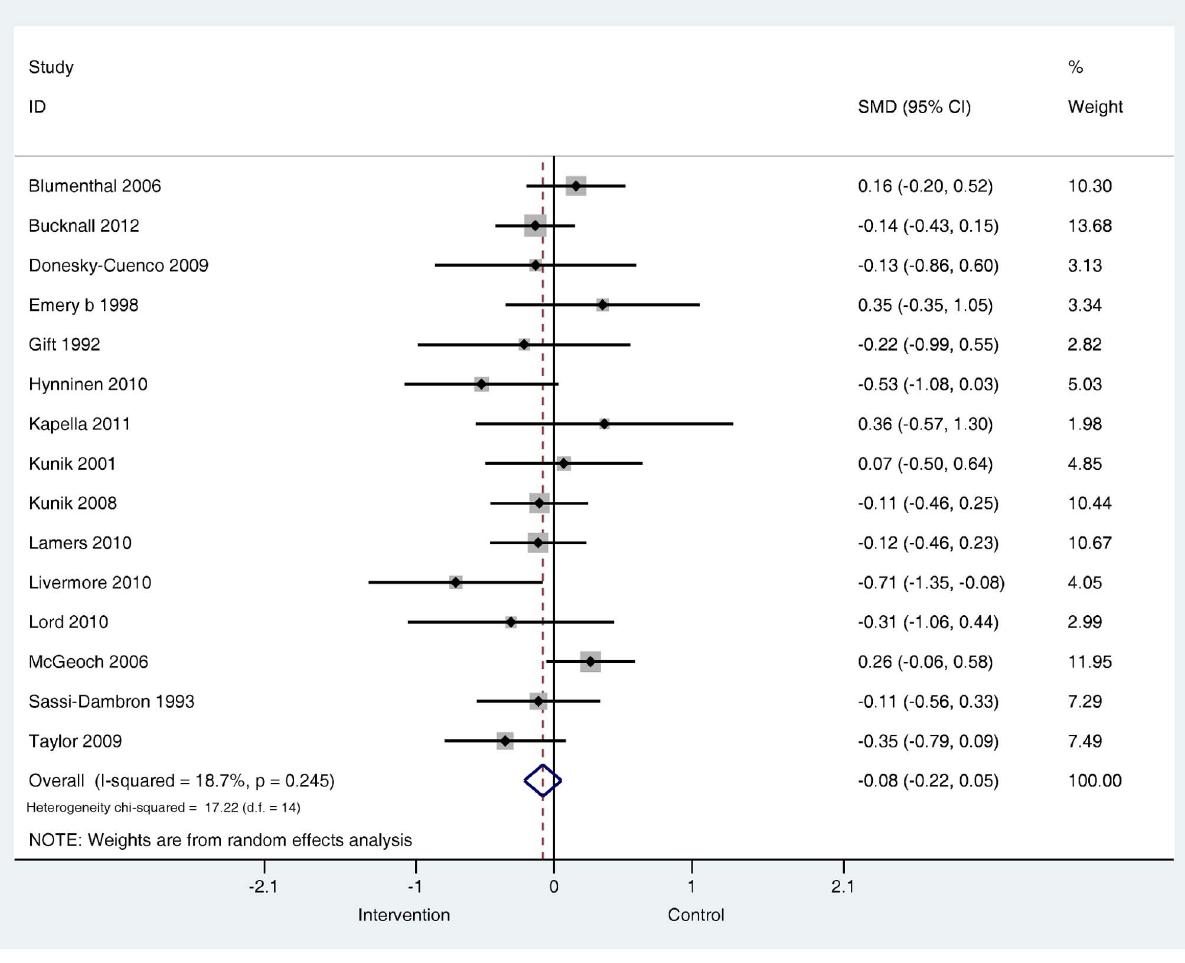
Figure 9. Effects on self-reported symptoms of anxiety in sub-group of non-exercise based complex interventions. Note: Random effects model used. 95% CI=95% confidence interval; SMD=standardised mean difference.